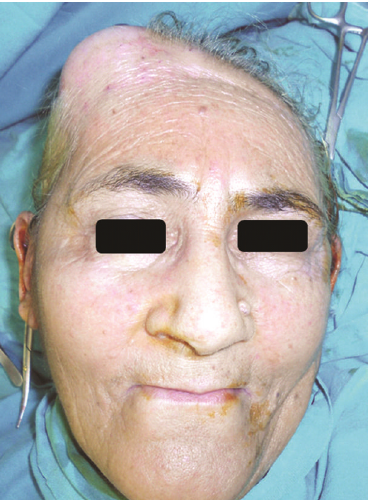
Figure 1: Preoperative view of the patient with a 6cm diameter mass on the right frontoparietal region.